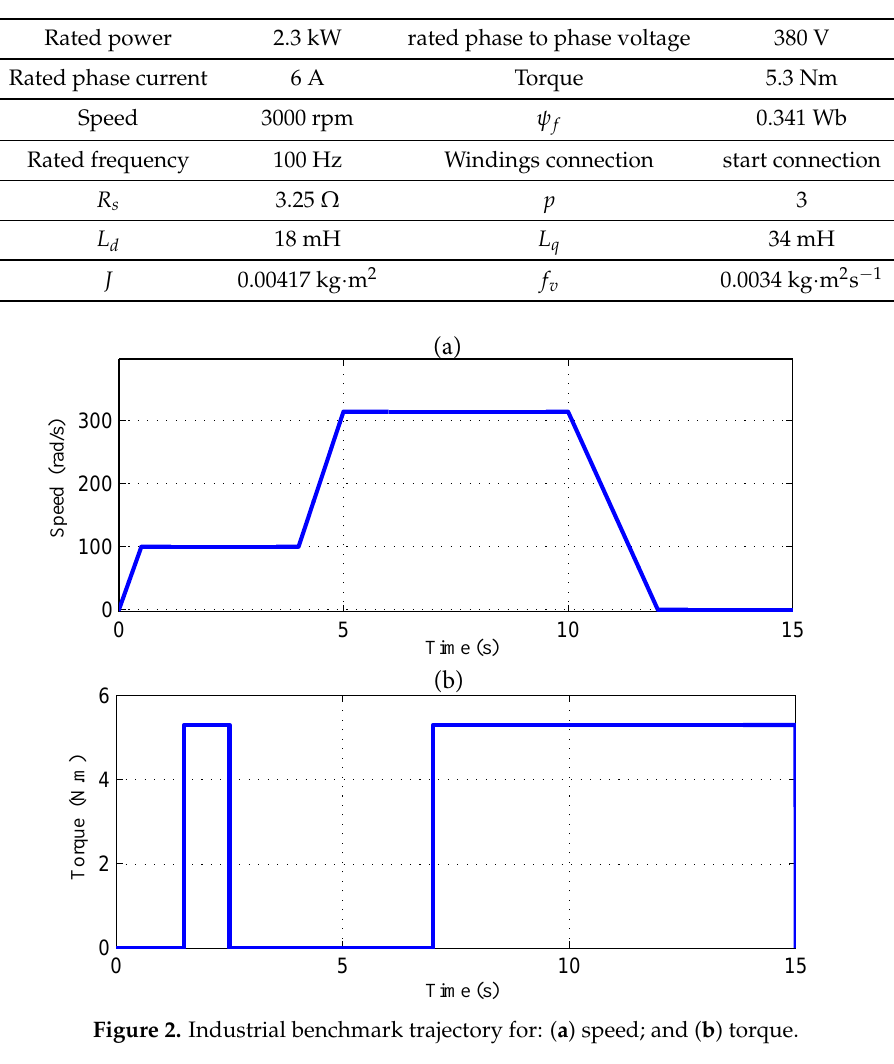
Table 1. Internal permanent-magnet synchronous machine (IPMSM) specifications.